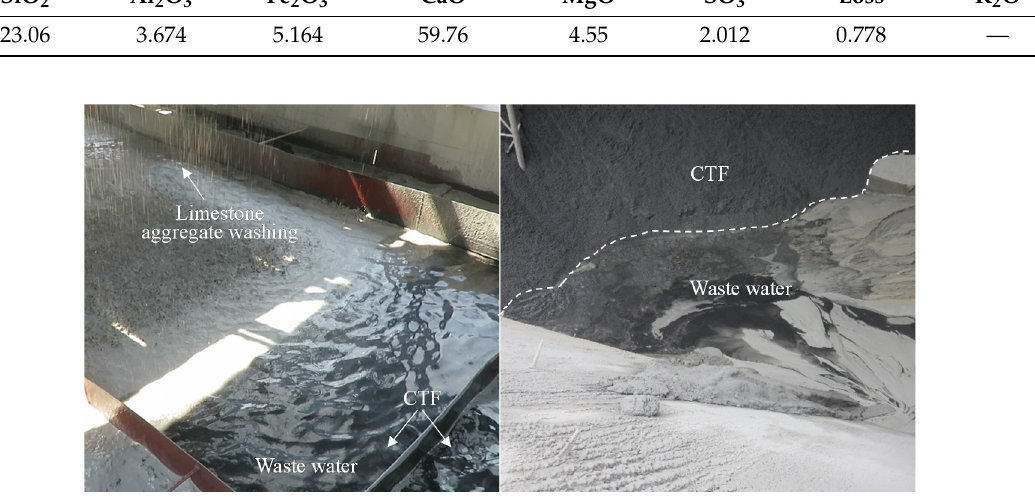
Figure 4. Collection of the CTF at WDD Hydropower station. Table 2. Chemical components of low-heat cement (% by weight).